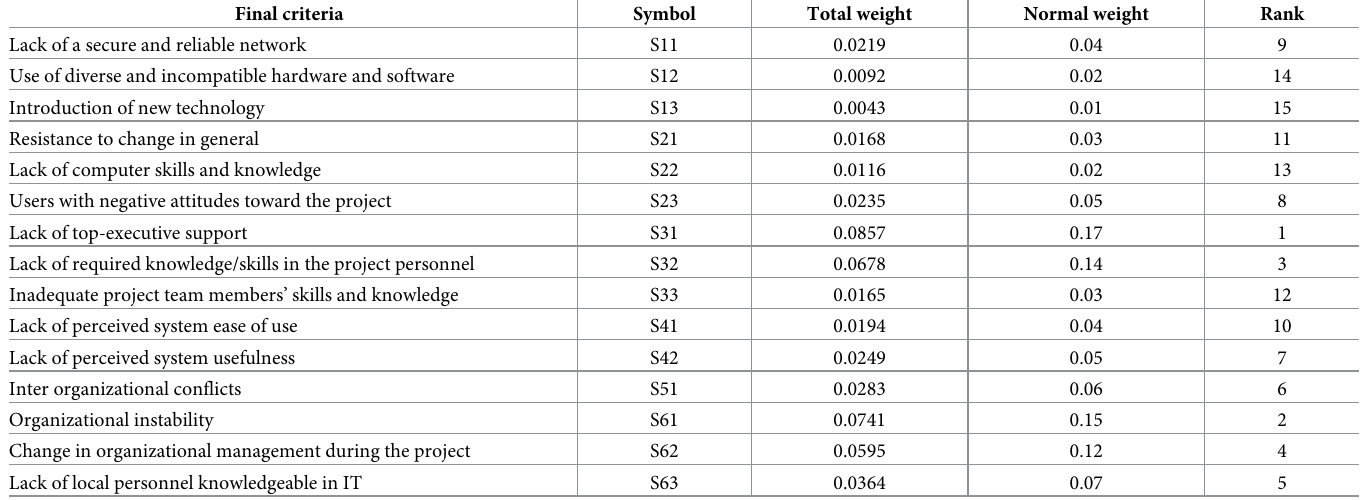
Table 11. The final weight of the indices based on the limit